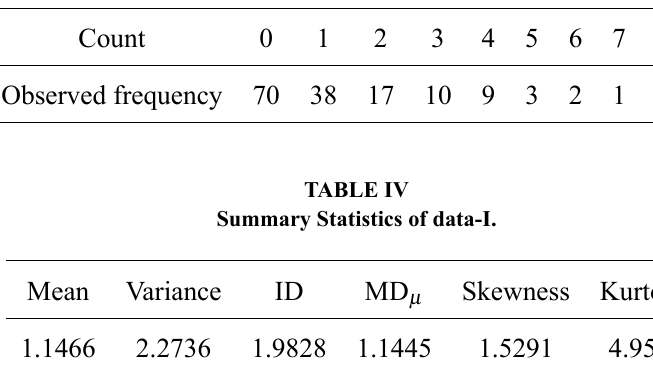
Counts of numbers of European red mites on apple leaves; data from Garman, 1951.